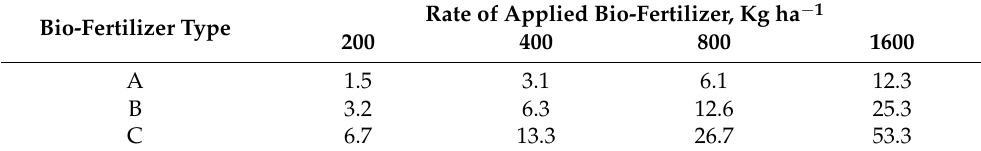
Table 5. Rate of applied ammonium nitrogen in the tested bio-fertilizers, kg ha − 1 . Bio-Fertilizer